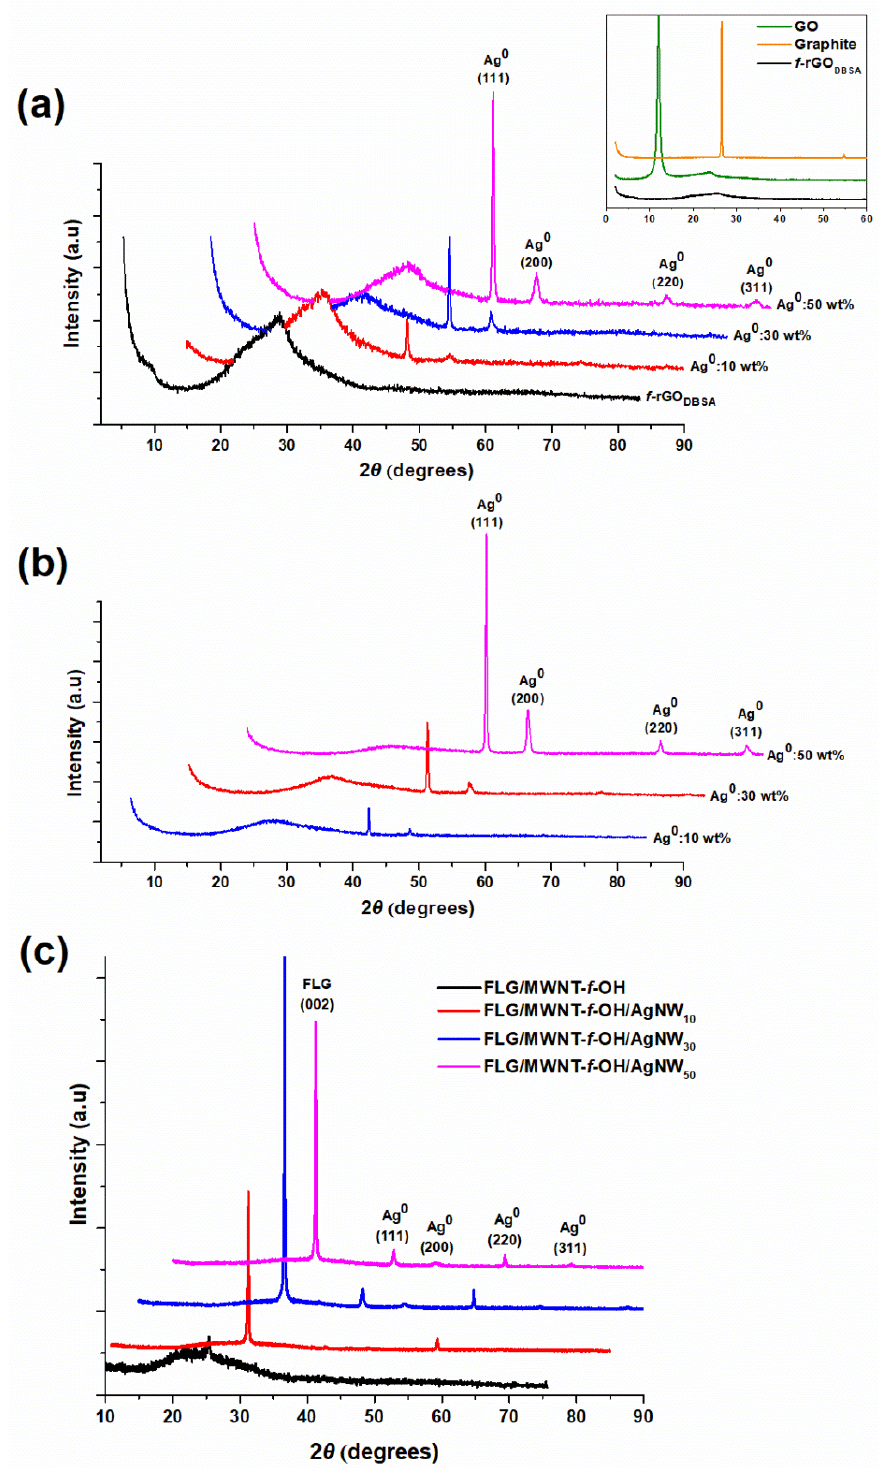
Figure 1. XRD patterns of f -rGO DBSA /AgNWs hybrid systems with three different metal loadings (10, 30, and 50 wt %) prepared with ( a ) the physical mixture method and ( b ) the in situ reduction method. XRD patterns of graphite, GO, and f -rGO DBSA are also given for comparison reasons (inset of ( a )); ( c ) XRD patterns for FLG/MWNT- f -OH/AgNWs nanohybrids with different metal loadings (0, 10, 30, and 50 wt %).